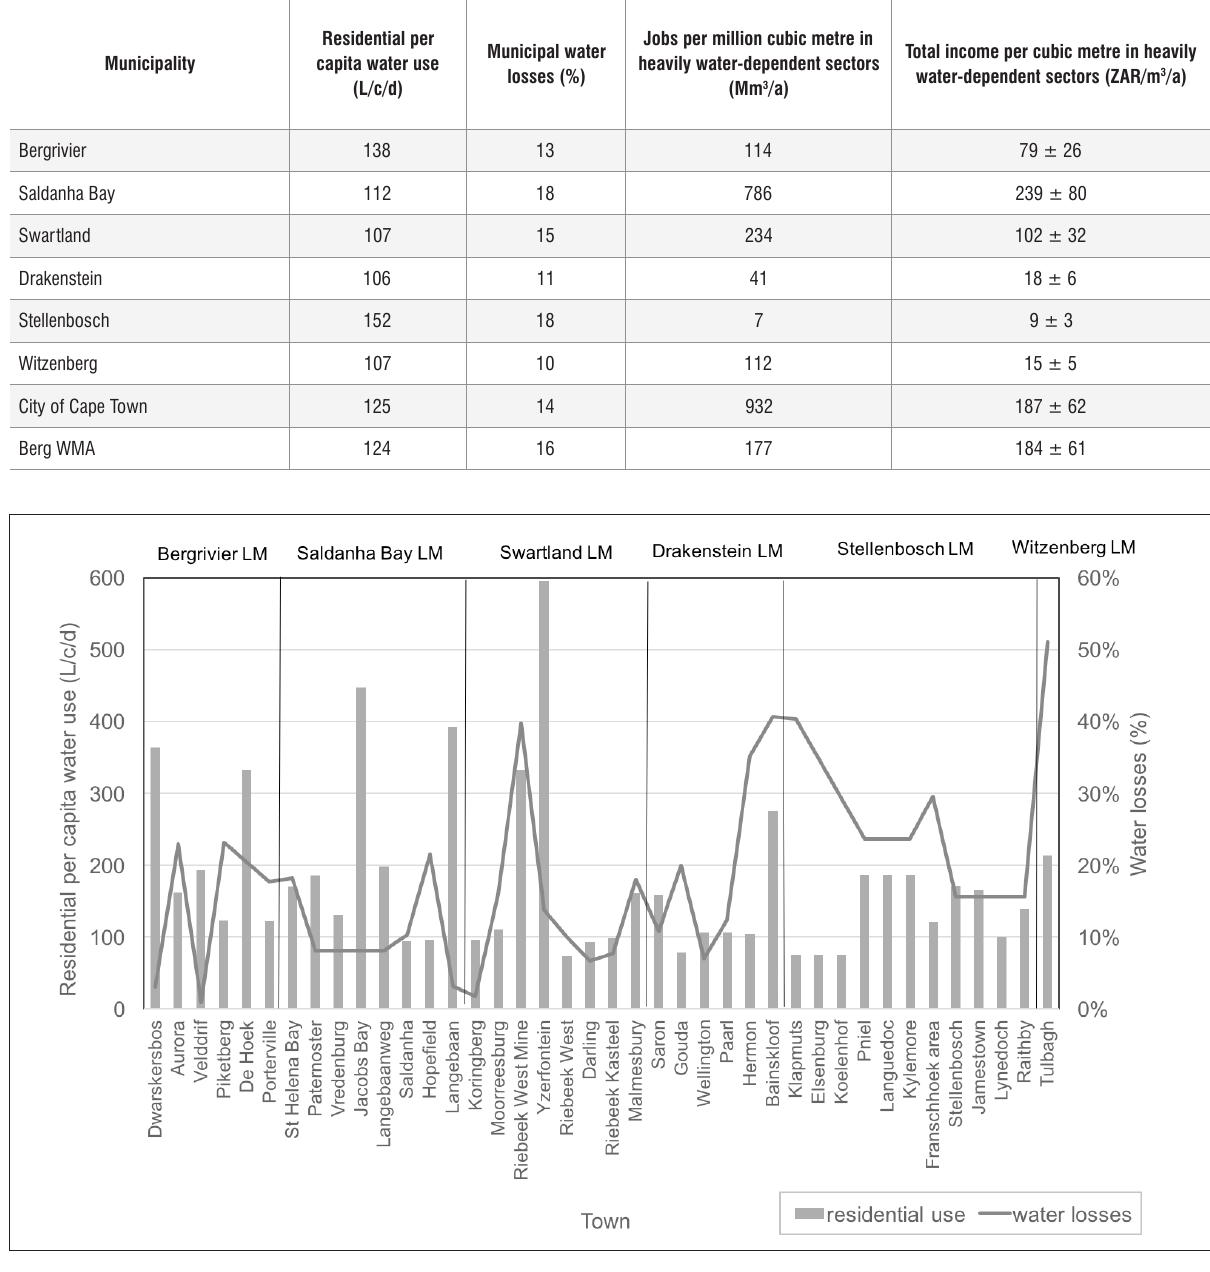
Table 2: Indicators of water-use efficiency in the Berg Water Management Area (WMA)